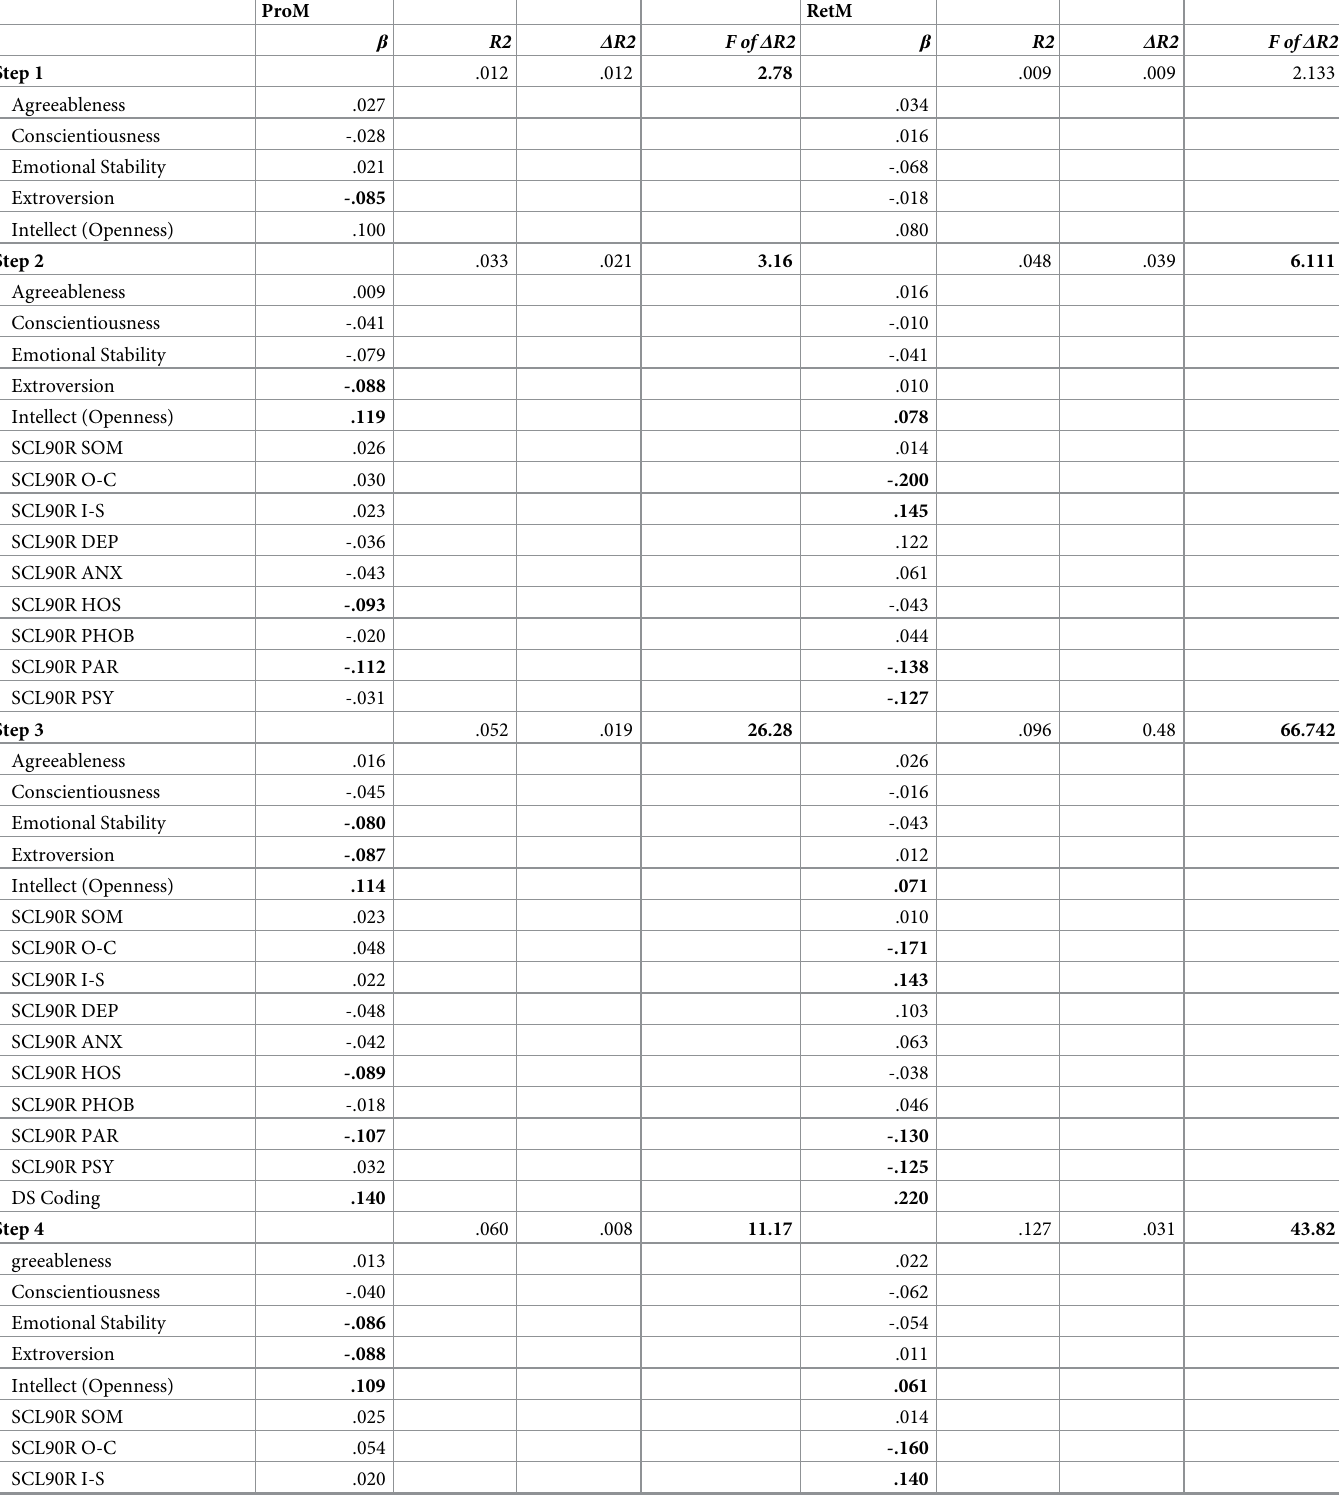
Table 7. Summary of hierarchical regression analyses predicting ProM versus RetM from personality, symptoms of psychopathology, and cognitive